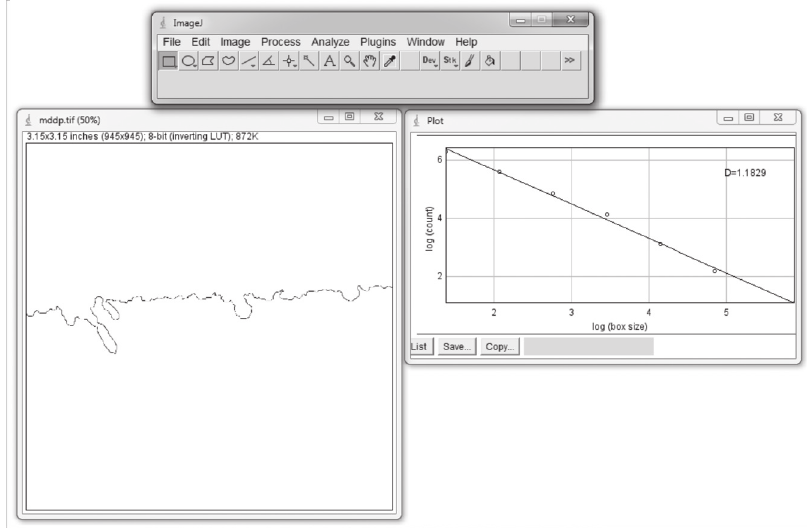
Figure 2- ImageJ software used to obtain the fractal dimension, represented by the value D